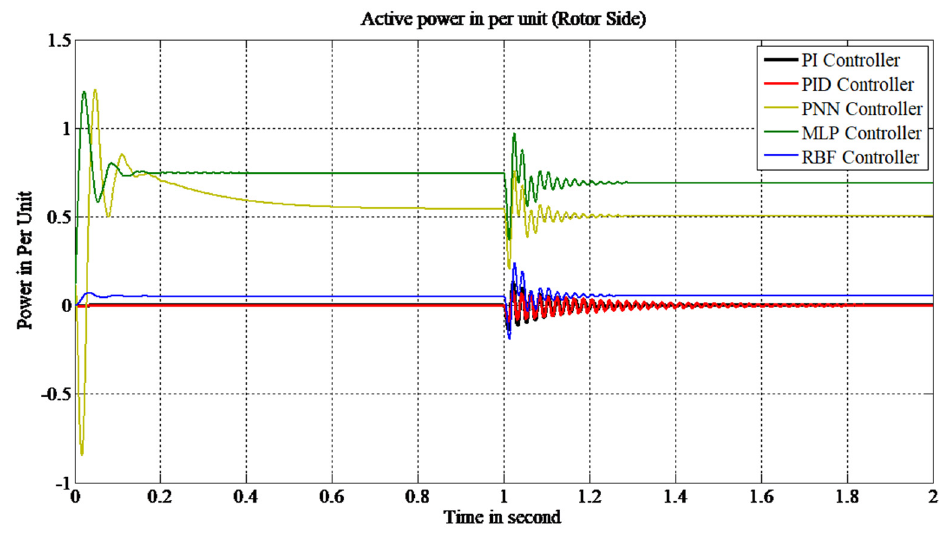
Figure 9. Active power at stator.